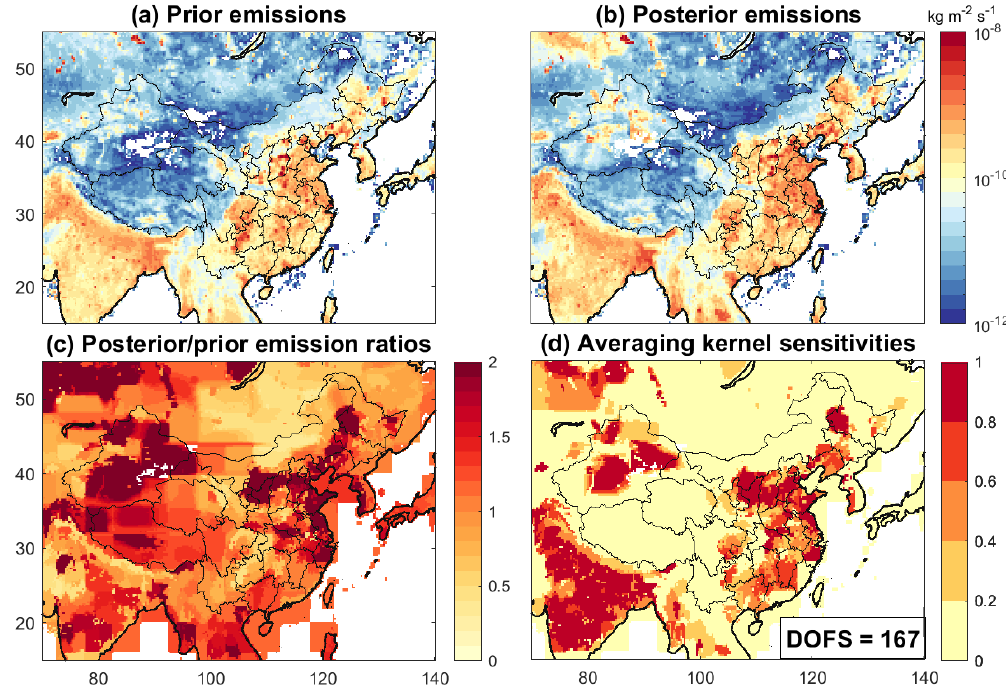
Figure 4. Optimization of methane emissions over East Asia in 2019 from inversion of TROPOMI observations. Results are from the base inversion and are shown on the 0 . 25 ◦ × 0 . 3125 ◦ grid. (a) Prior estimates of methane emissions, summing the contributions from the sectors in Fig. 3 plus additional minor sectors as given in Table 1. (b) Posterior methane emissions from the TROPOMI inversion. (c) Posterior/prior emission ratios. (d) Averaging kernel sensitivities. The averaging kernel sensitivities are the diagonal elements of the averaging kernel matrix and display the ability of the observations to quantify emissions independently from the prior estimates (1 = fully; 0 = not at all). The degrees of freedom for signal (DOFS, defined as the trace of the averaging kernel matrix) is given in the